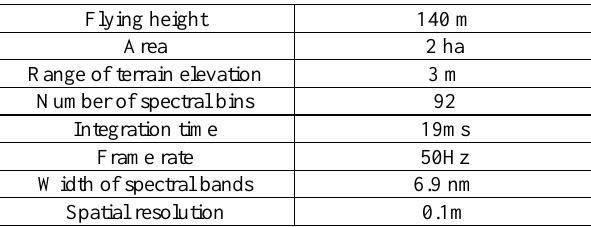
Table 3: Summary of the hyperspectral scanning